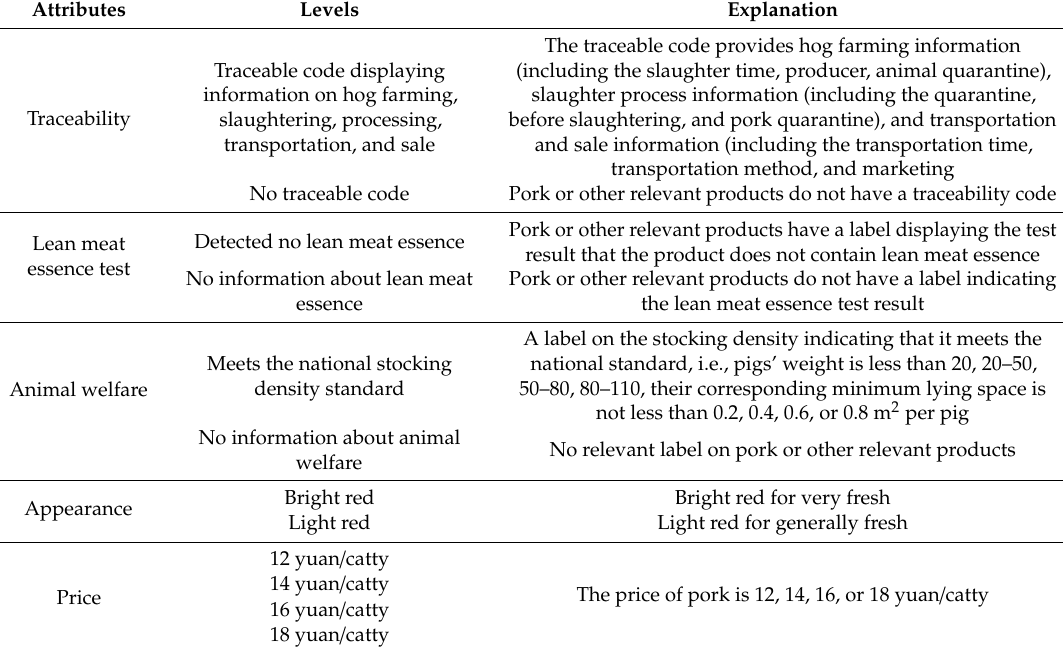
Table 1. The attributes of pork hindquarters and their corresponding